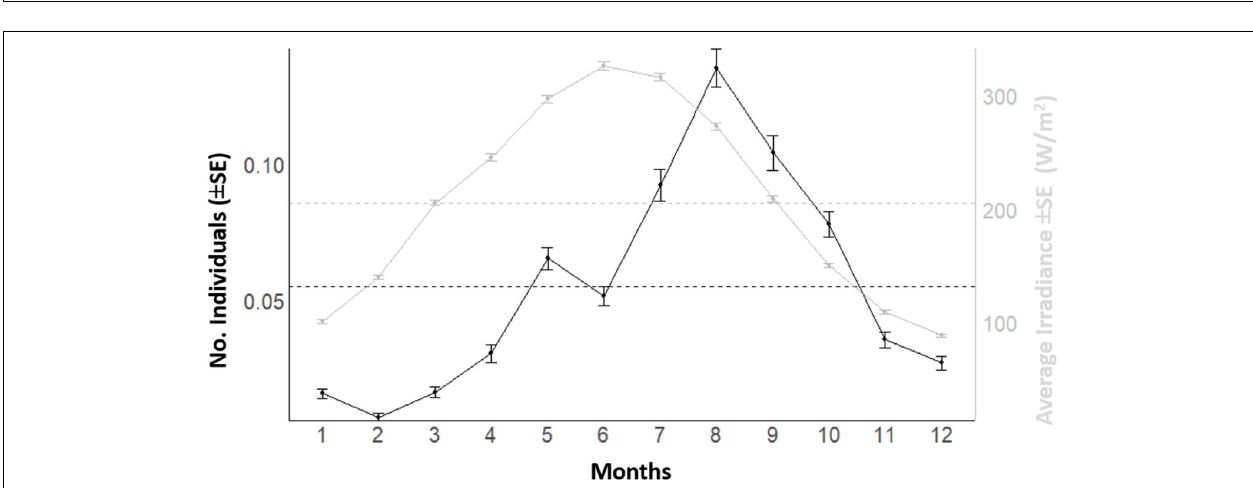
FIGURE 6 | Waveform analysis output plots for visual counts of D. dentex and solar irradiance during different seasons (i.e., winter, spring, summer, and autumn) from 8 years (i.e., 2012–2019) of monitoring at the OBSEA video platform. The dashed horizontal line is the MESOR.